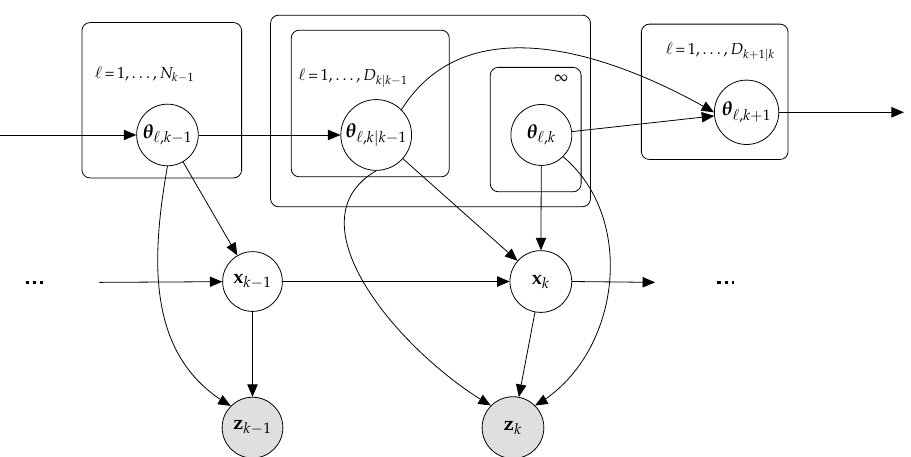
Figure 1. Graphical model capturing dependence in obtaining posterior